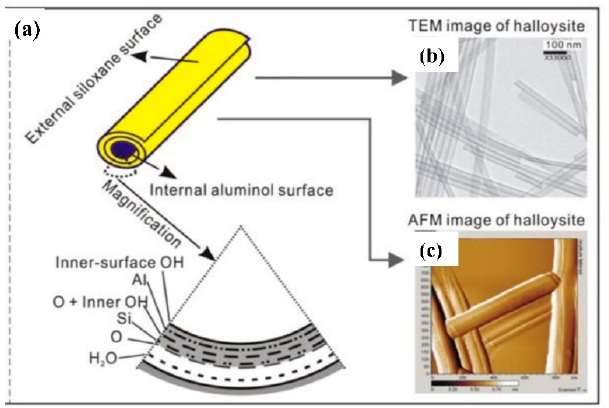
Figure 2. Diagram of halloysite crystalline structure ( a ), halloysite particle ( b ), TEM images of halloysite ( c ), and Atonic Force Microscopy (AFM) image of halloysite ( d ). Adapted from Saharudin (2017) [35].